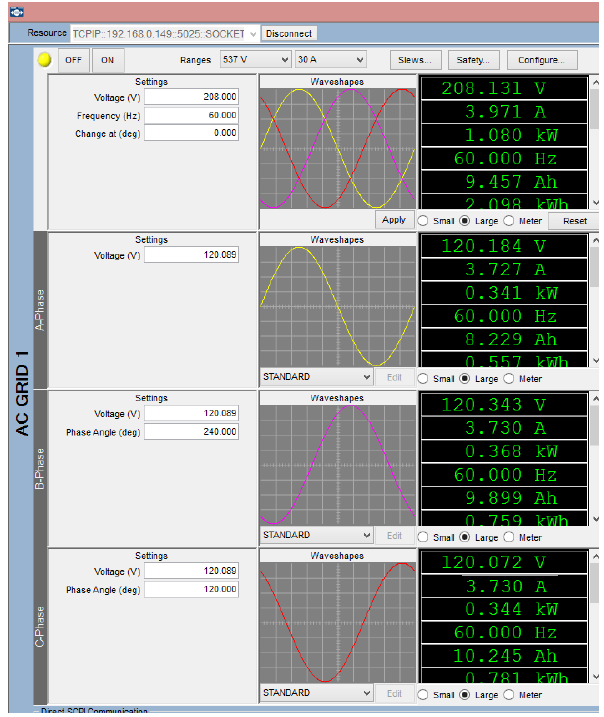
Figure 24. Hardware results using grid simulator NHR 9400 panel for real power = − 1 kW and reactive power = 0.5 kvar under balanced grid